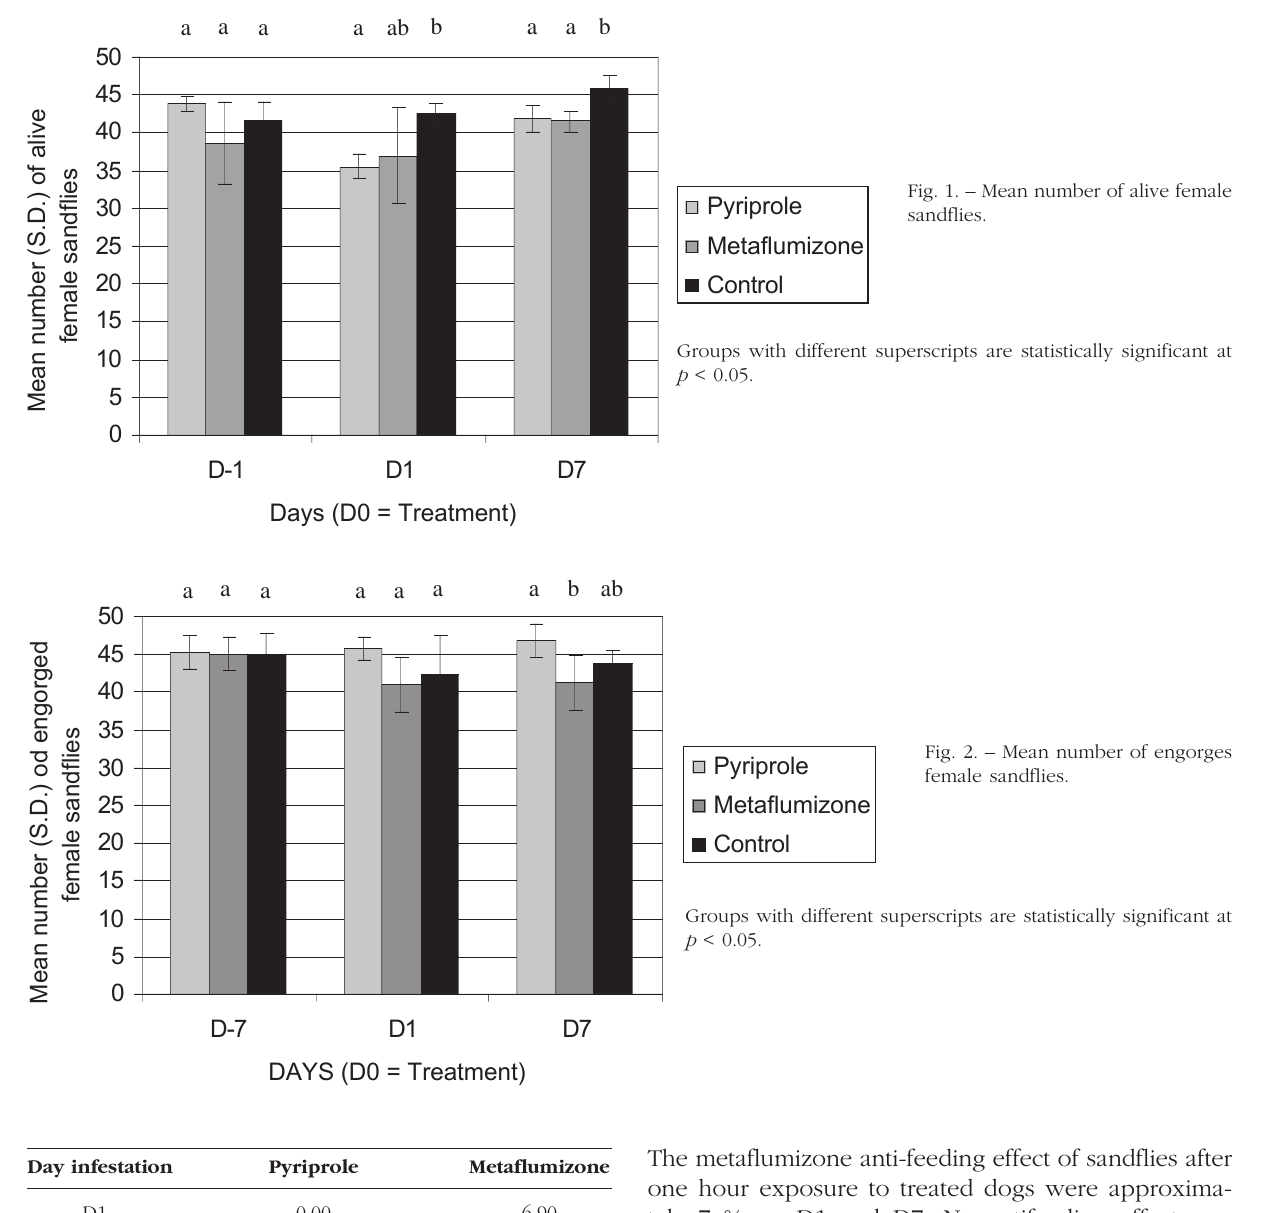
Fig. 1. – Mean number of alive female sandflies. Groups with different super- scripts are statistically significant at p < 0.05. Groups with different superscripts are statistically significant at p < 0.05.